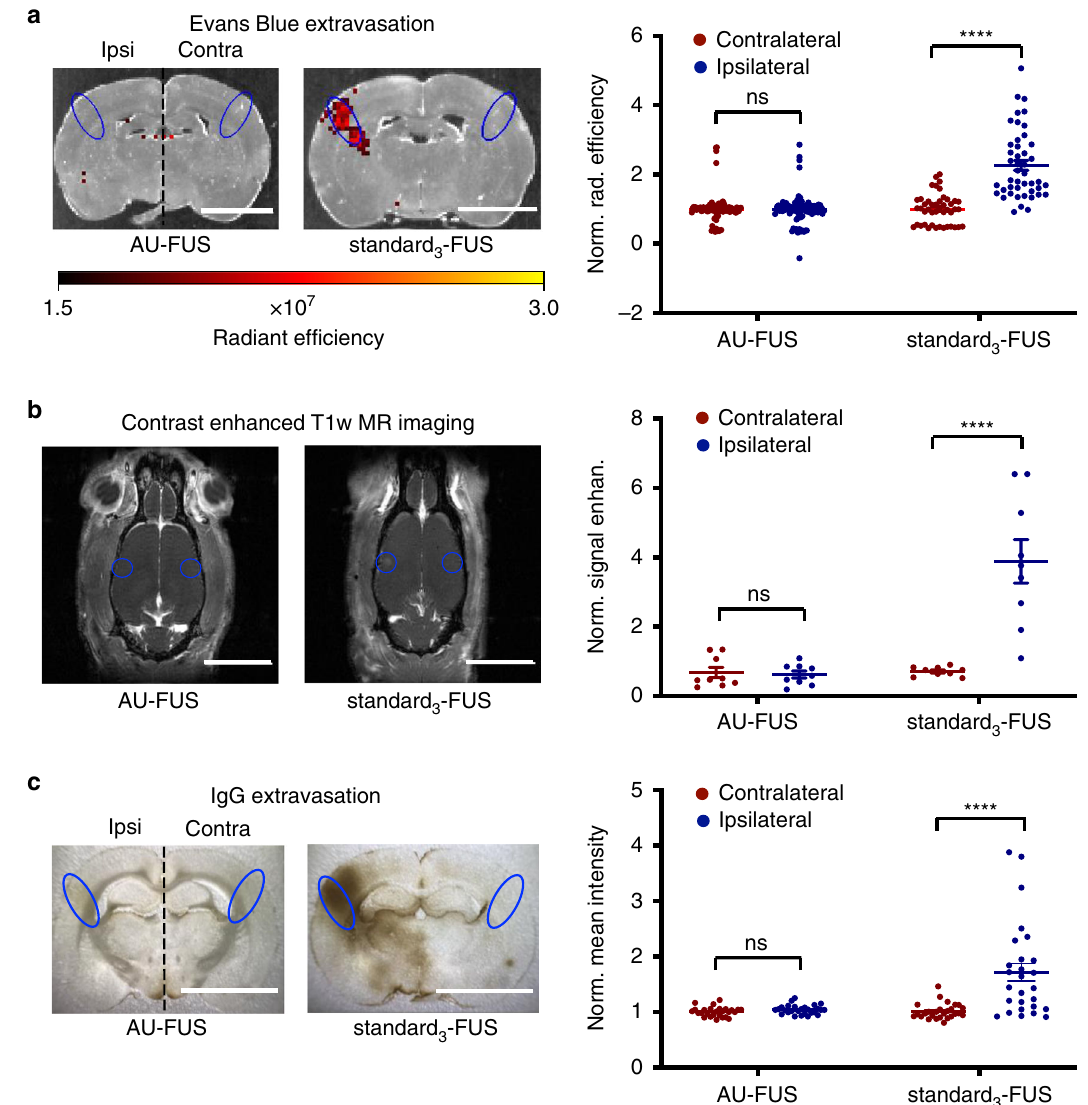
Fig. 5 Preservation of blood – brain barrier integrity following AU-FUS. a Evans Blue extravasation. Evans Blue was IV-injected. Representative IVIS spectrum images, at the FUS target location (vS1) following AU-FUS (muscimol-loaded UC-carriers with FUS, left image) vs. standard 3 -FUS (right image). Regions of interests (ROIs) (1.5 ×3.5 mm, blue) were measured as radiant ef fi ciency ipsilateral to FUS application and were compared to the contralateral vS1 (scale bar: 0.5 cm). Radiant ef fi ciency values within ROIs for AU-FUS and standard 3 -FUS sequences were quanti fi ed [ n = 90 (6 rats × 15 brain sections) for AU-FUS; same rats as in Fig. 3c; n = 45 (3 rats × 15 brain sections) for standard 3 -FUS]. Pairwise Mann – Whitney rank-sum test AU-FUS (ipsilateral vs. contralateral, p = 0.6577), standard 3 -FUS (ipsilateral vs. contralateral, **** p < 0.0001). b MRI contrast agent extravasation. Animals were injected with Omniscan (Gd) and imaged. Representative brain images at the FUS target location (vS1) after AU-FUS (left image) compared to standard 3 -FUS sequence (right image). ROIs (1.0 ×1.0 mm, orange, approximate ROI location) were measured as signal enhanced T1-weighted MR images, ipsilateral to FUS application, which were compared to the contralateral vS1 (scale bar: 1.0 cm). See Supplementary Fig. 9 for zoomed images. Baseline-subtracted contrast- enhanced T1-weighted MR image ROIs using AU-FUS and standard 3 -FUS sequences were quanti fi ed [ n = 9 (3 rats × 3 brain sections) for AU-FUS and standard 3 -FUS]. Pairwise Mann – Whitney rank-sum test, AU-FUS (ipsilateral vs. contralateral, p = 0.9494), standard 3 -FUS (ipsilateral vs. contralateral, **** p < 0.0001). c IgG immunohistochemistry. Photographic images of immunohistochemical IgG staining of brain sections from the center of the focal volume following AU-FUS (left photo) vs. standard 3 -FUS (right photo) (scale bar: 0.6 cm). Normalized mean intensity values from ROI analysis of bright fi eld images of brain sections stained for IgG were quanti fi ed. Intensities were obtained from ROIs (1.5 × 3.5 mm) contralateral and ipsilateral to FUS treatment within the FUS focal volume [ n = 27 (3 rats × 9 sections) for AU-FUS; n = 27 (3 rats × 9 sections) for standard 3 -FUS] and normalized with the average contralateral mean intensity. Pairwise Mann – Whitney rank-sum test AU-FUS (ipsilateral vs. contralateral, p = 0.0970), standard 3 -FUS (ipsilateral vs. contralateral, **** p <